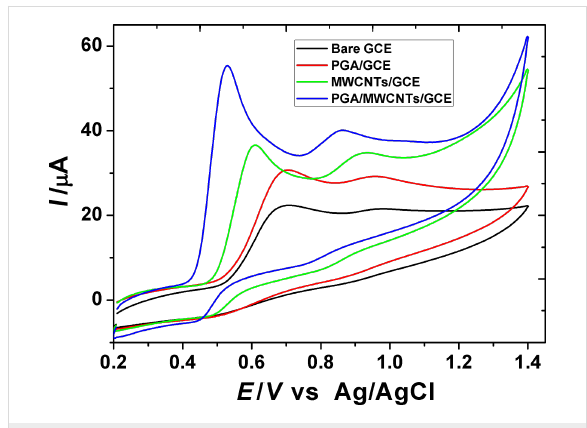
Figure 2: Cyclic voltammograms of 1.0 mM GA in 0.2 M H 3 PO 4 at a scan rate of 50 mV s − 1 on bare GCE, PGA/GCE, MWCNT/GCE and